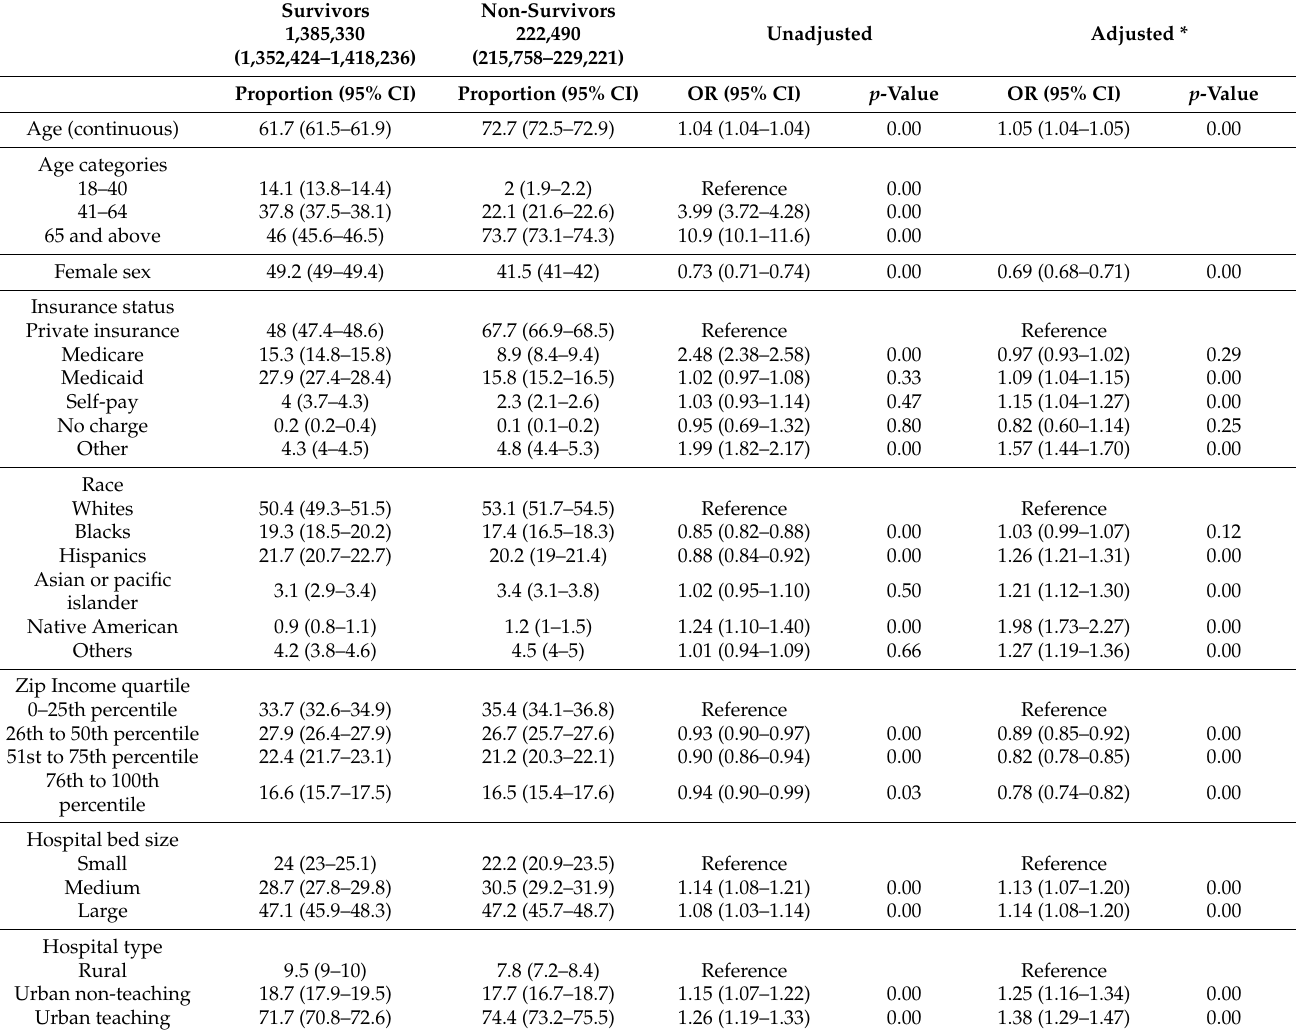
Table 6. Logistic Regression for Socioeconomic Predictors of